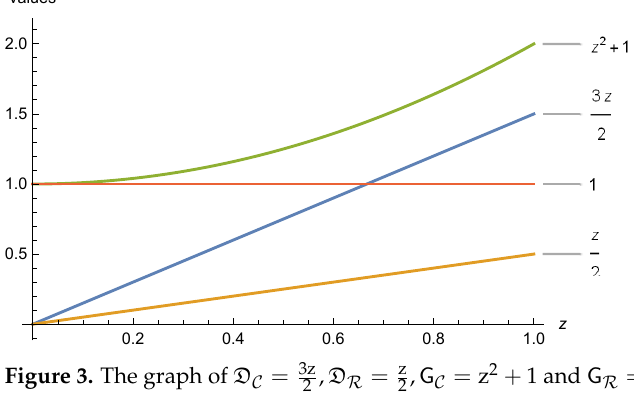
, D R = z , G C = z 2 + 1 and G R = 2 2